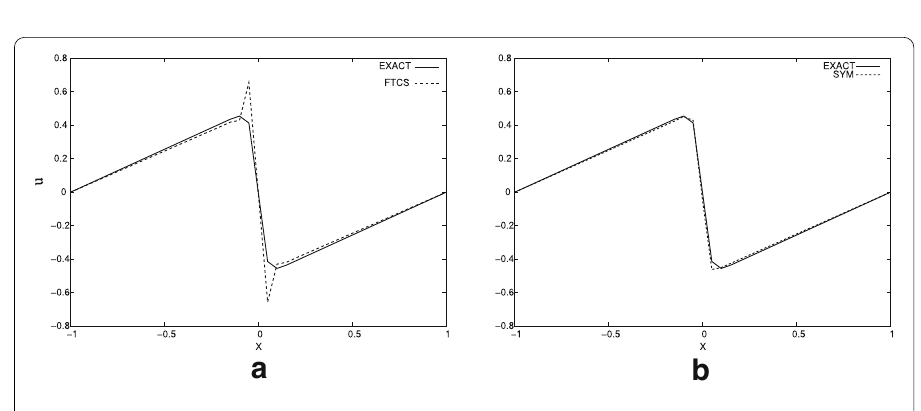
Fig. 25 Velocity profiles with λ = 0, λ = 1, λ = 2 and λ = 3, at t = 1s. a Invariantized FTCS scheme. b Invariantized Lax–Wendroff scheme. c Invariantized Crank–Nicolson scheme